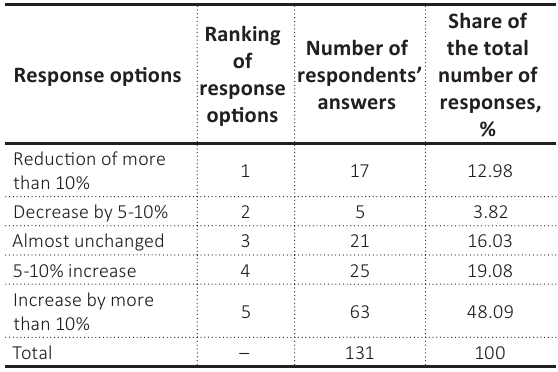
Table 6. The results of the survey “Has your income changed in the last two years?”